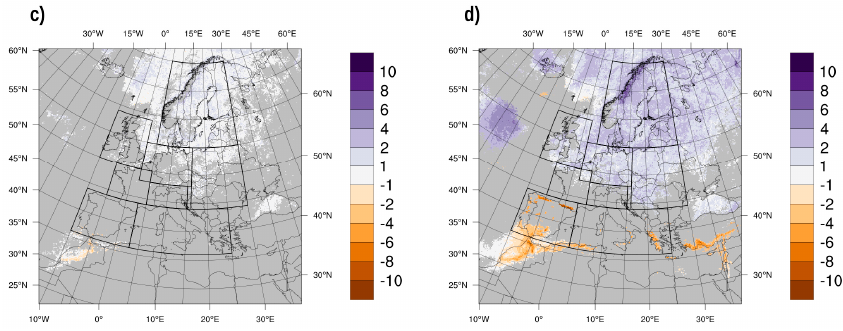
Figure 4. Same as Figure 1, but for heavy precipitation days in days per year.